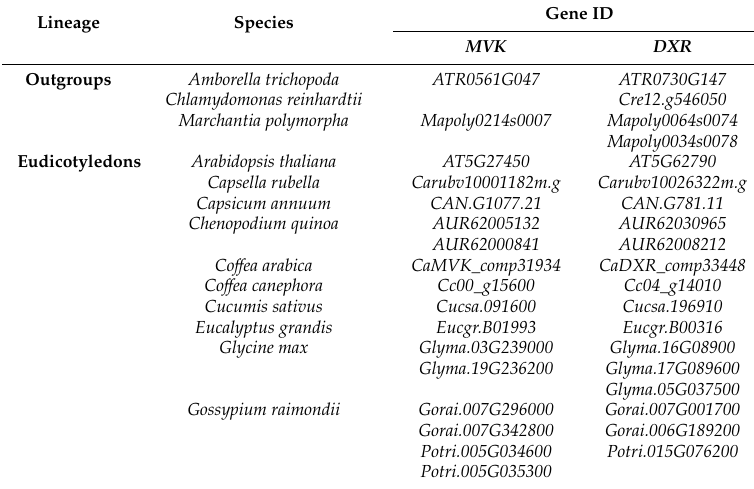
Figure 1. Phylogenetic tree of the analyzed species based on NCBI species taxonomy. This tree was constructed with PhyloT [26] and edited using iTOL [27]. An asterisk (*) indicates that the species lacks an MVK gene. Table 1. Identification of MVK and DXR genes in 24 plant species.